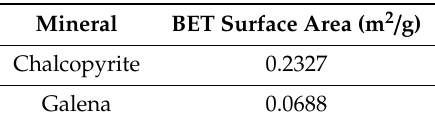
Table 1. Brunauer–Emmett–Teller (BET) surface area of 38–108 µ m size fraction of minerals used in microflotation tests. Mineral